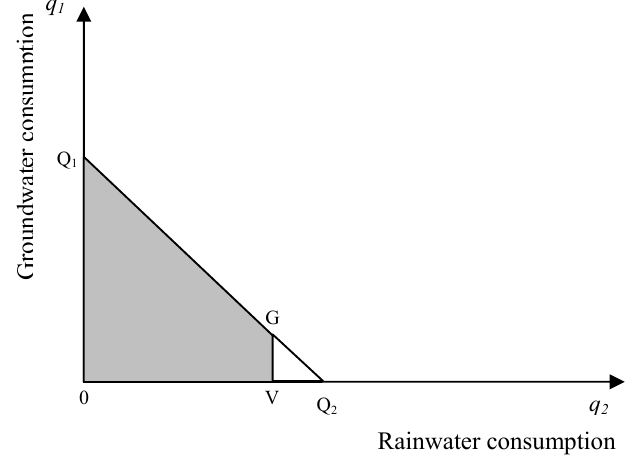
Figure 7. Region of feasible solutions. (Q means quantity required for irrigation; q means consumption of rainwater; G means intersection consumption of groundwater; q 2